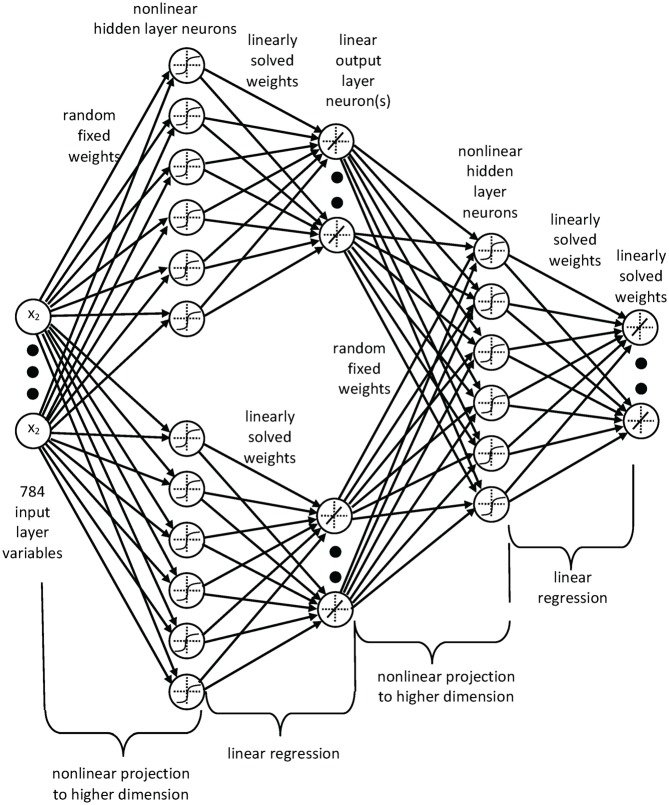
Combined two-layer RF-CIW-ELM and RF-C-ELM network.This figure depicts the structure of our multilayer ELM network that combines a CIW-RF-ELM network with a C-ELM network, using what is effectively an autoencoder output. Note that the middle linear layer of neurons can be removed by combining the output layer weights of the first network with the input layer weights of the second; we have not shown this here, in order to clarify the development of the structure.